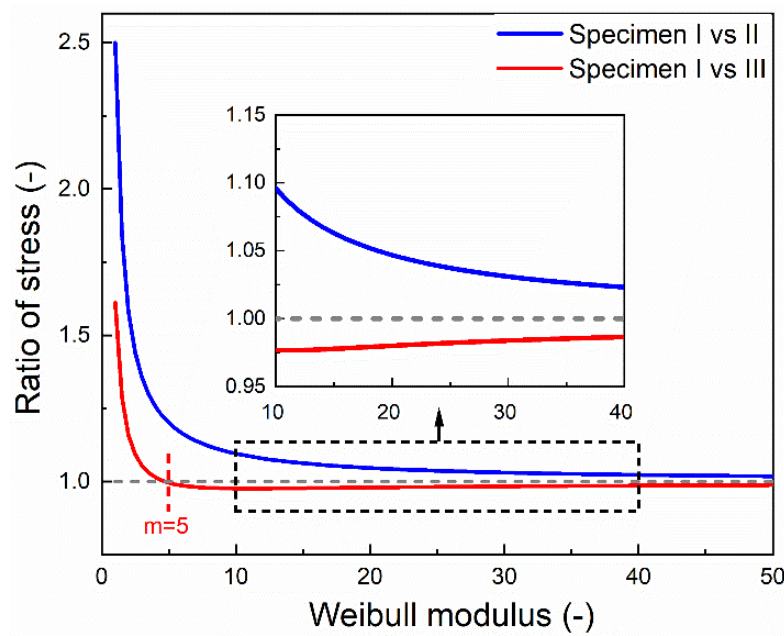
Figure 3. The ratio of stress for the same probability of failure as a function of the Weibull modulus. Shown are the two analyzed comparisons between test Specimens I and II (blue curve) and test Specimens I and III (red curve).